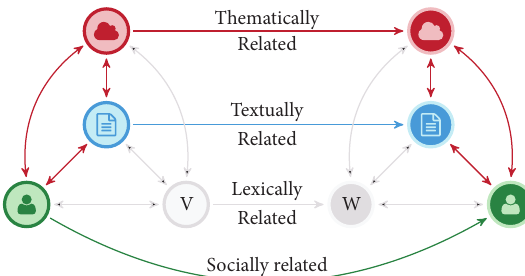
Figure 9: Schematic depiction of the informational sources of linking topics (red vertices) in author topic networks as a function of the textual relatedness of two texts (blue vertices) (that belong to of a corresponding LMN—see Definition 1) and the social layer L 1 relatedness of corresponding authors (green vertices) (that belong to layer L of a corresponding LMN). Bidirectional red arcs denote 2 arcs of the corresponding margin layers in Definition